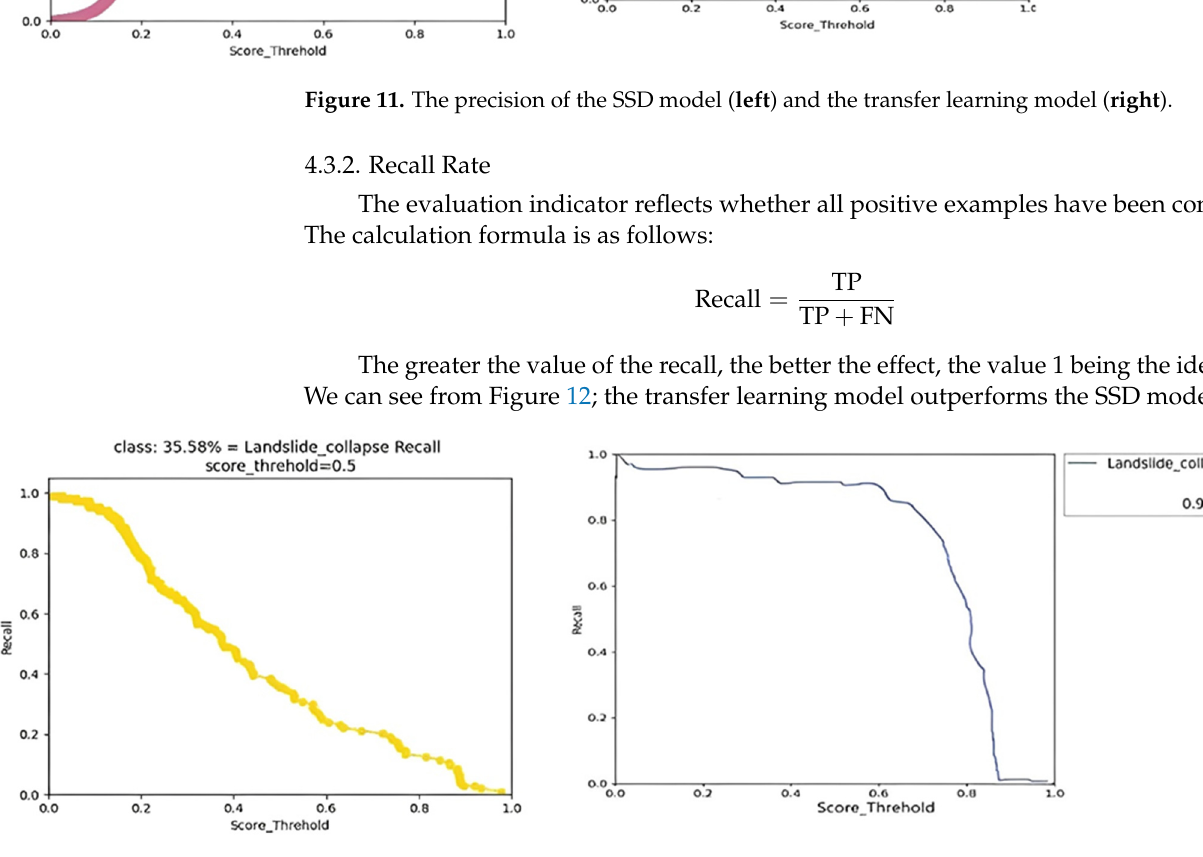
Figure 12. The recall of the SSD model ( left ) and the transfer learning model ( right ).